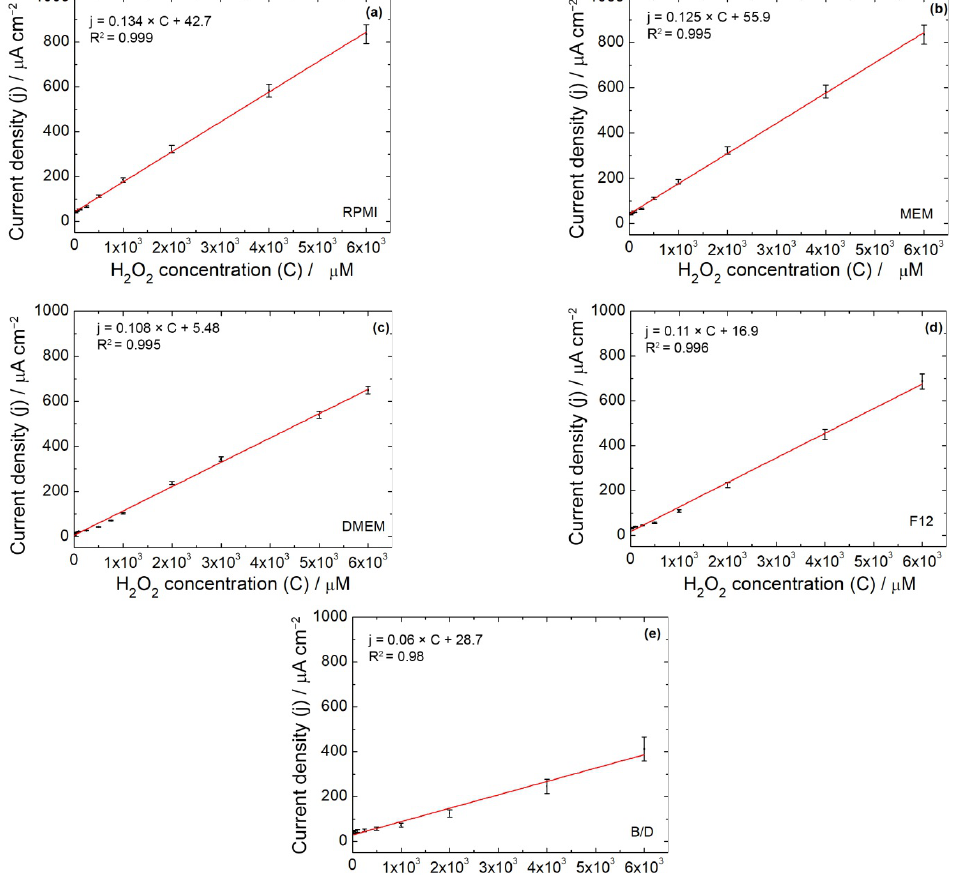
Figure 4. Calibration line obtained with LSV in: ( a ) RPMI alone, ( b ) MEM alone, ( c ) DMEM alone, ( d ) Ham’s F12 alone, ( e ) B/D alone (N = 3). Using MEM, RPMI and DMEM, the effect of dilution is almost negligible (Table 2), while for Ham’s F12 and B/D, there is still an increase in sensitivity after dilution. Further- more, in those media, better results were obtained with LSV compared to CH. This effect could be attributed to the fastness of the LSV compared to CH. In fact, the whole LSV experiments lasted less than 60 s, while CH experiments lasted for at least 600 s, due to the requirement for signal stabilization. During stabilization, H 2 O 2 reacts at the electrode surface along with all the other chemical species present in the culture media. This may strongly affect the signal output due to a bio-fouling effect, especially with more complex mediums such as Ham’s F12 or B/D. Thus, the AuNPs-rGO-based sensor can work with every kind of medium with both LSV or CH measurements but, depending on the me- dium and the expected H 2 O 2 concentration, it is necessary to use LSV or CH as the elec- trochemical technique to have a high sensitivity. In particular, the sensor can detect low concentrations of H 2 O 2 in RPMI, MEM and DMEM medium with both LSV and CH, while for B/D, CH can be used when high concentrations of H 2 O 2 are expected. LSV must be used to detect low concentrations of H 2 O 2 (Tables 1 and 2). From these results, it can be concluded that the proposed sensor is adaptable for use in different media. Table 2. Performance of the AuNPs-rGO-based sensors using LSV as the electrochemical technique in different culture media diluted and not diluted with PBS. Medium Sensitivity µAµM −1 cm −2